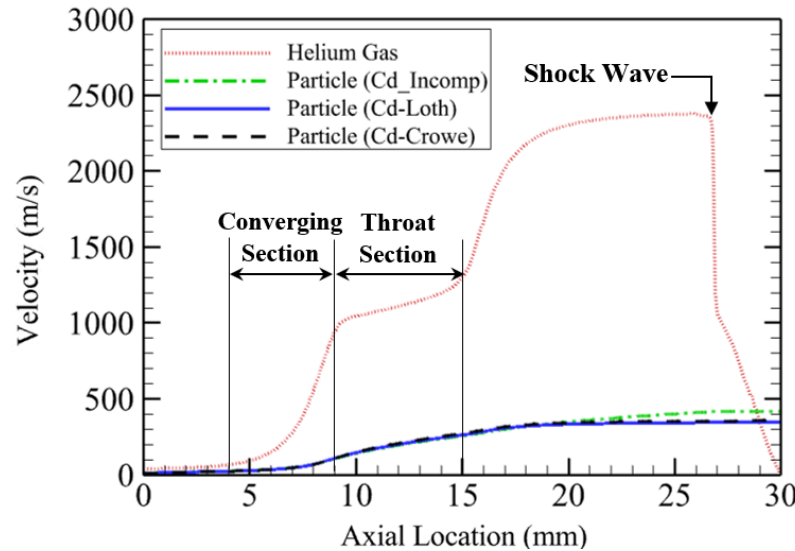
Figure 11. Effect of drag coefficients on centerline particle velocity , 𝑑 𝑝 = 5 μm .